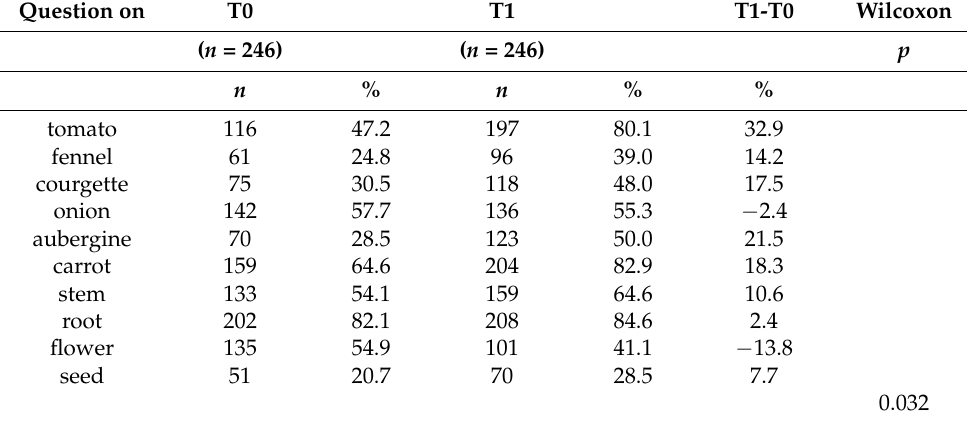
Table 5. Evaluation of the knowledge increase at the end of didactical